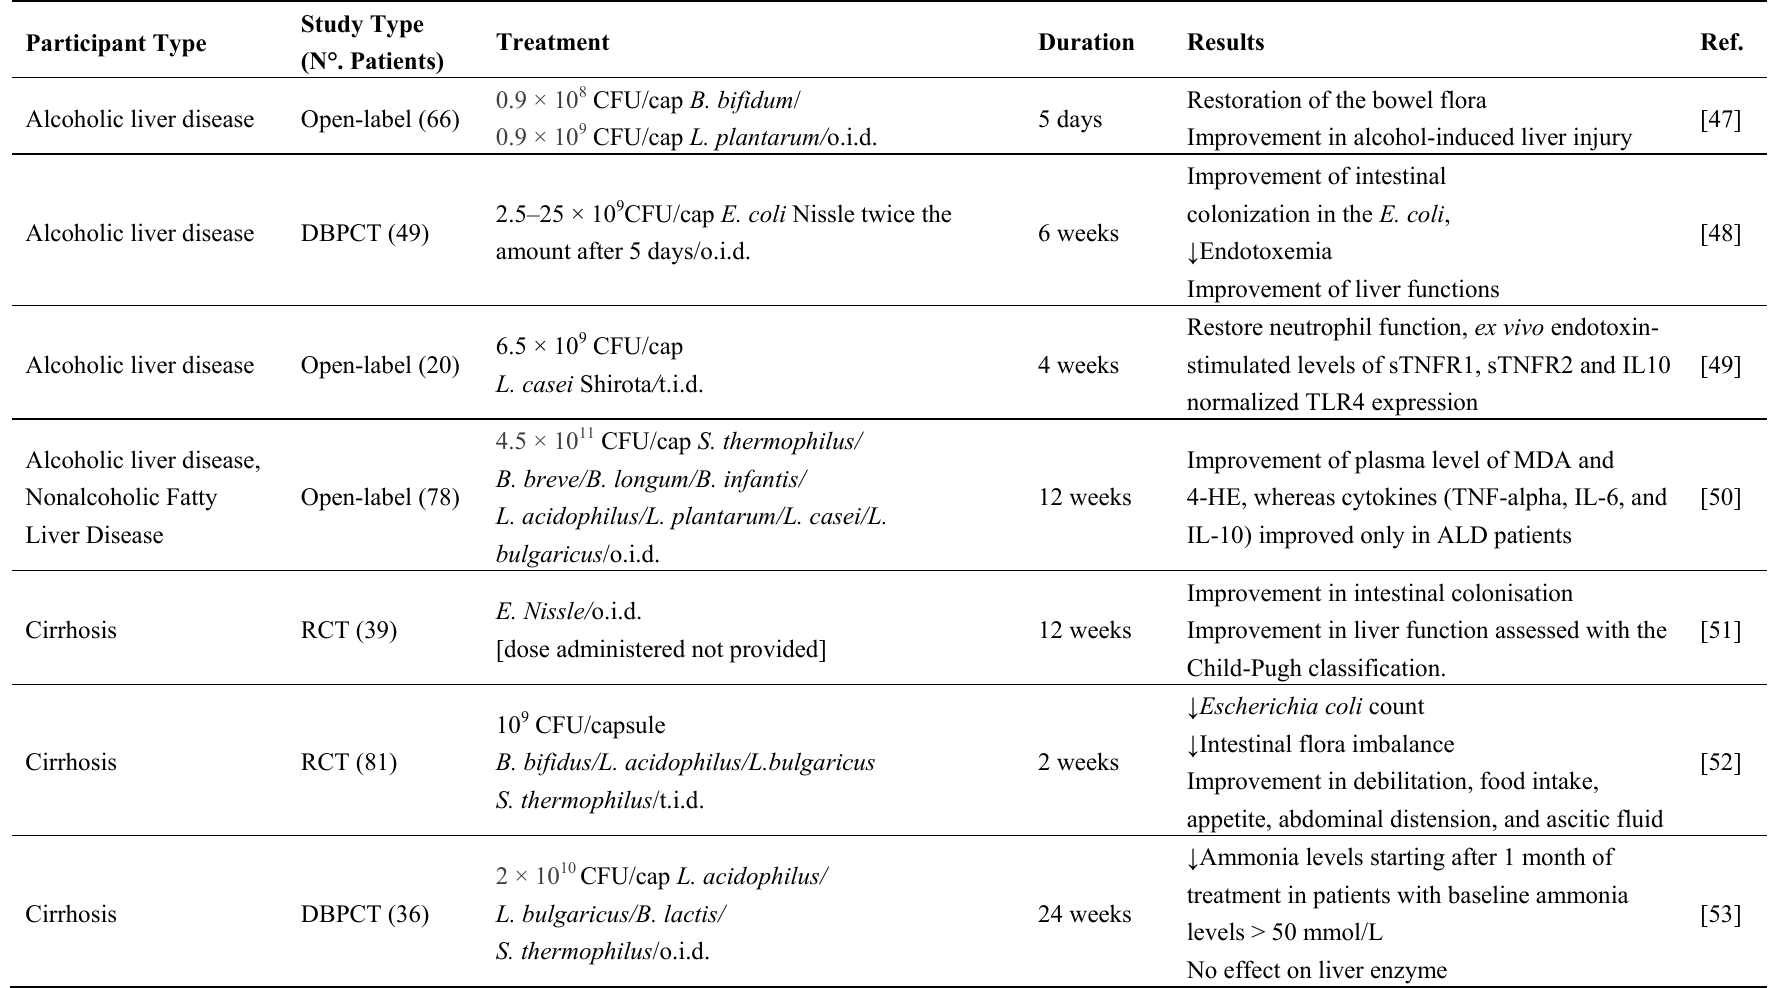
Table 2. Clinical studies of probiotics and liver